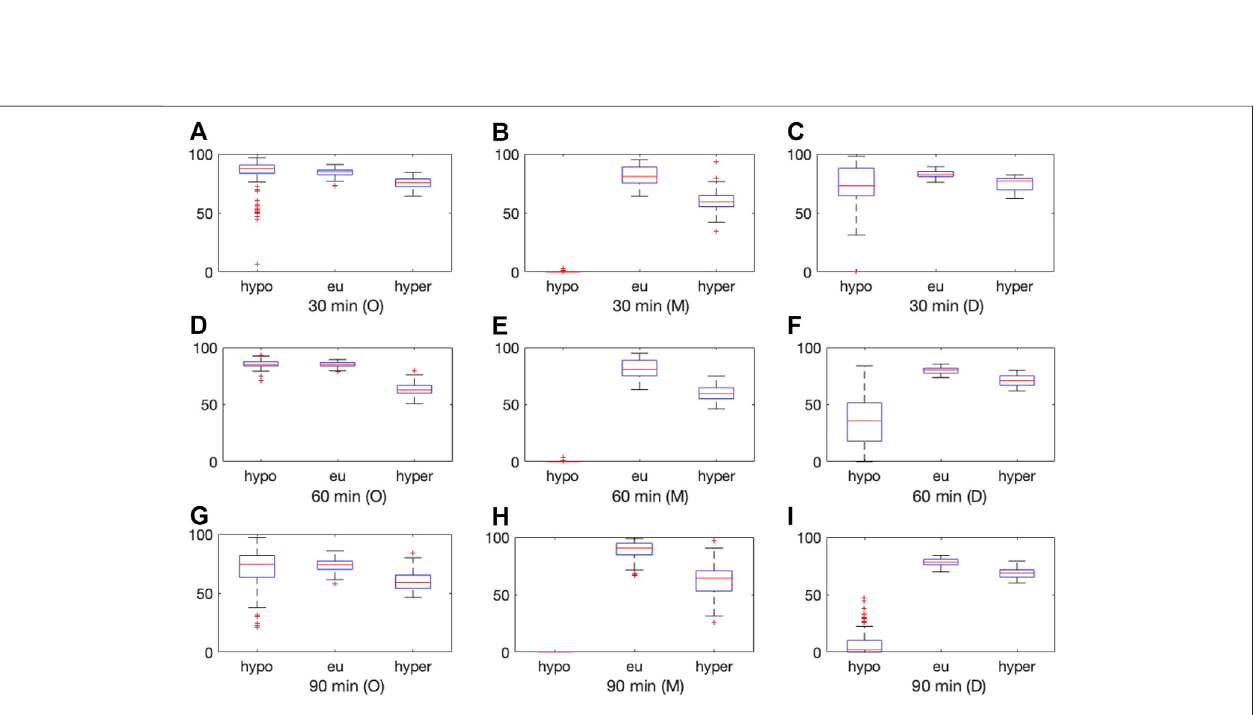
Frontiers in Applied Mathematics and Statistics |